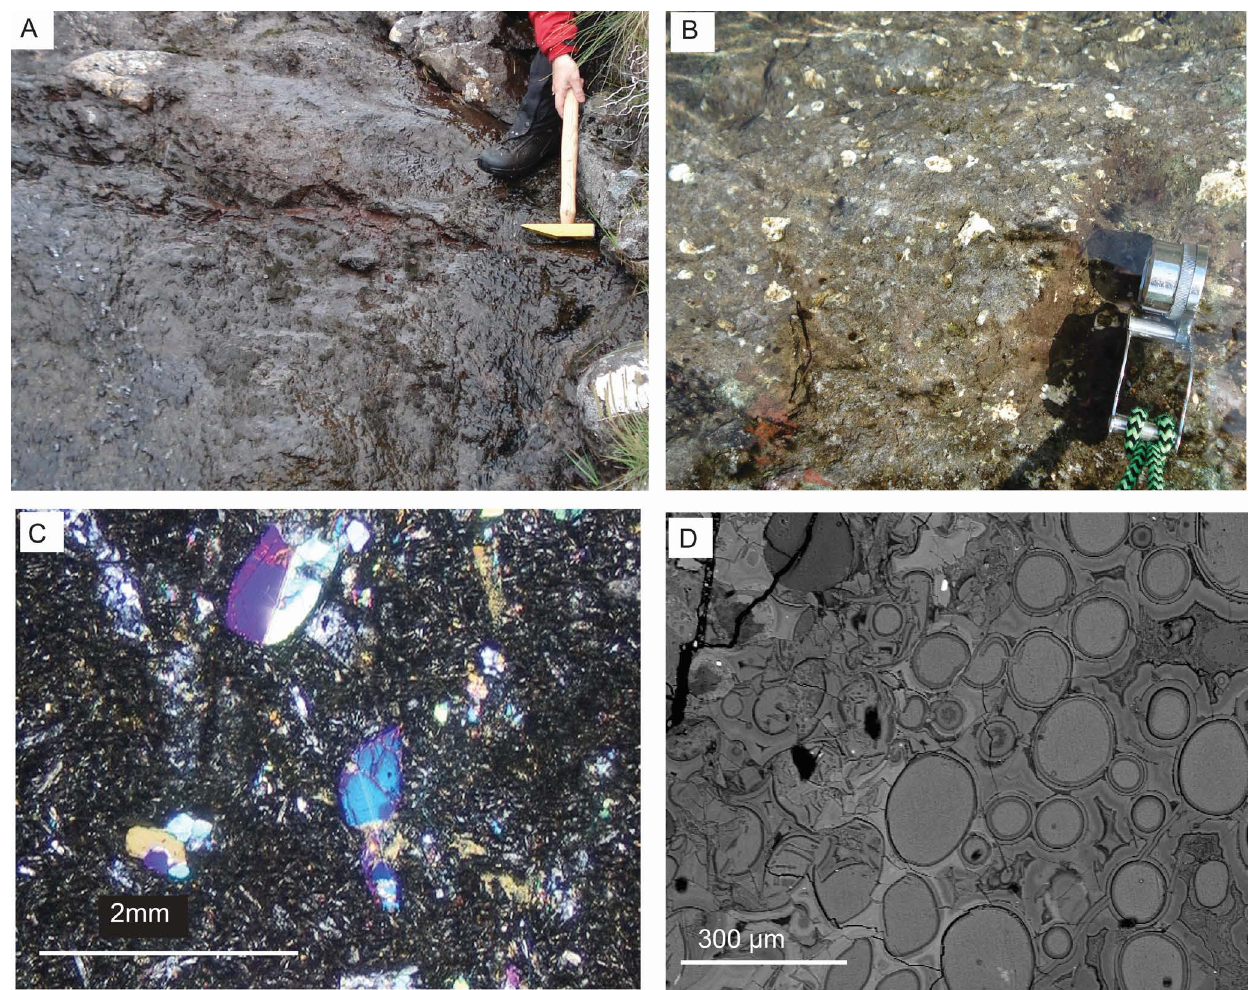
Figure 4: [A] 5.5 cm-thick dark red, fissile paleosol grading into underlying amygdaloidal basalt within Allt Nan Suidheachan, (log 16, 290m height, see Supplementary Material 1). [B] Amgydaloidal basalt above paleosol in [A]. Reddening in lower left is the colour of the laterally discontinuous paleosol. [C] Tholeiitic basalt containing zoned, twinned forsterite and randomly orientated bytownite groundmass laths, XP, field of view 2 mm (log 16, 355 m height, see Supplementary Material 1). [EMP backscatter image of bubble wall shards and axiolitic devitrification of bubble wall margins within fall deposit in Allt nan Suidheachan (log 16, 295 m height, see Supplementary Material